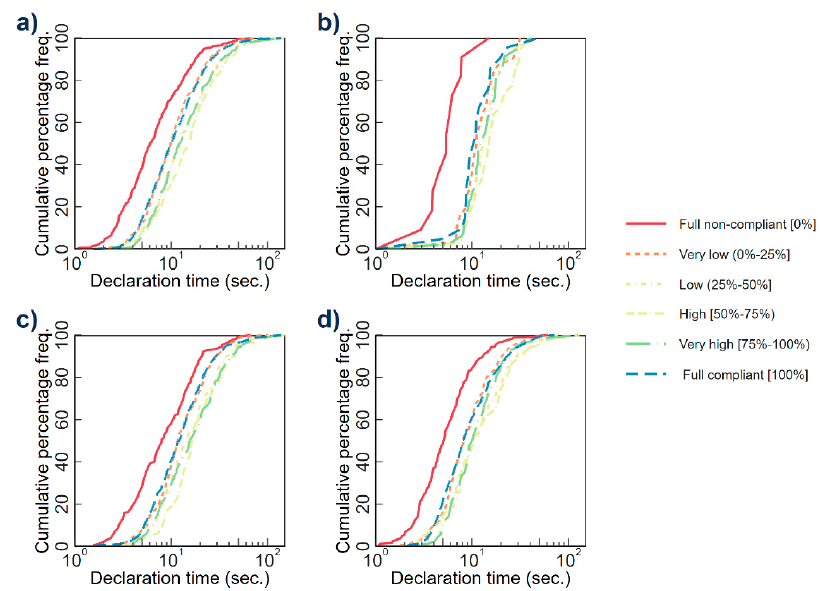
Figure 3. Declaration time and tax compliance level. ( a ) Declaration time of individual decisions by the level of tax compliance; ( b ) Individual average declaration time by mean tax compliance level; ( c ) individual-level for the first half of the experiment (round 1 to 8); and, ( d ) Individual-level for the second half of the experiment (round 9 to 16). Horizontal axis (declaration time) is in base-10 log scale.